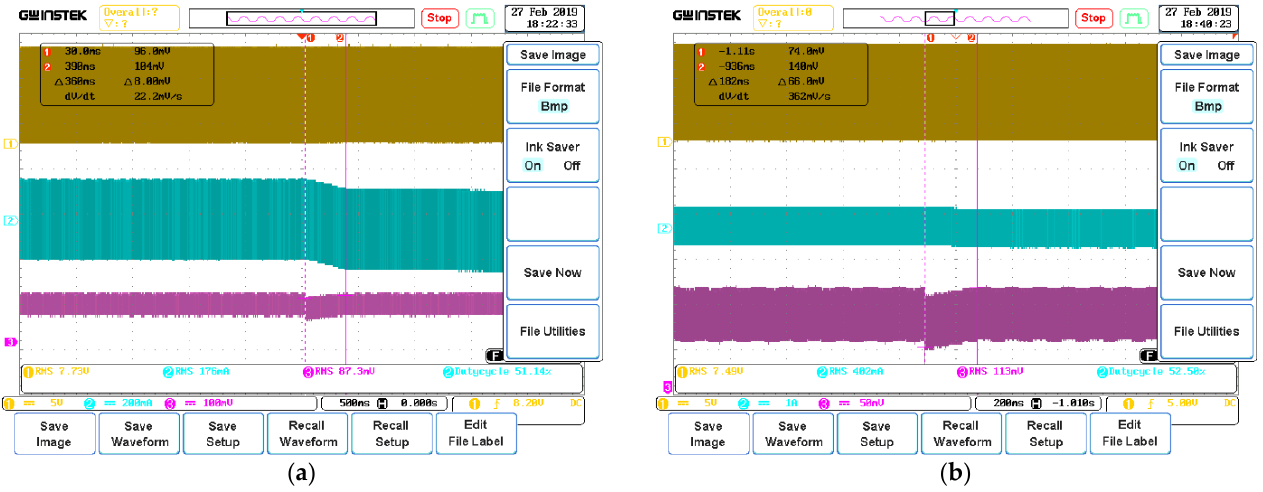
Figure 13. Testing the dynamics of the control system with the Ring XRE module at E zad = 500 lx and E zew = 200 lx ( a ) E zad = 750 lx and E zew = 200 lx ( b ).